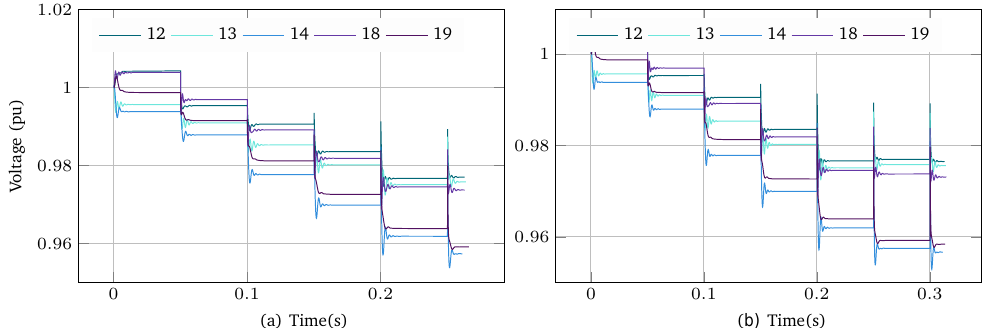
Figure 9. Voltage dynamics at each converter for load case 2. ( a ) Constant load model. ( b ) Frequency- dependent load